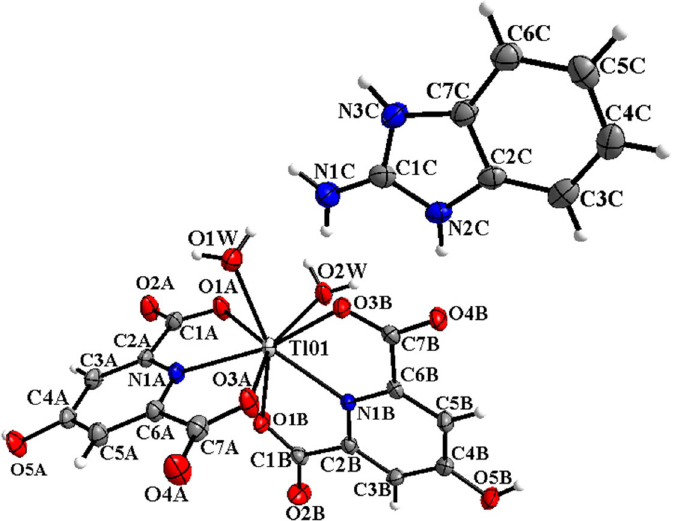
Figure 2. Molecular structure of C2 showing the atom numbering scheme with 50% probability of thermal